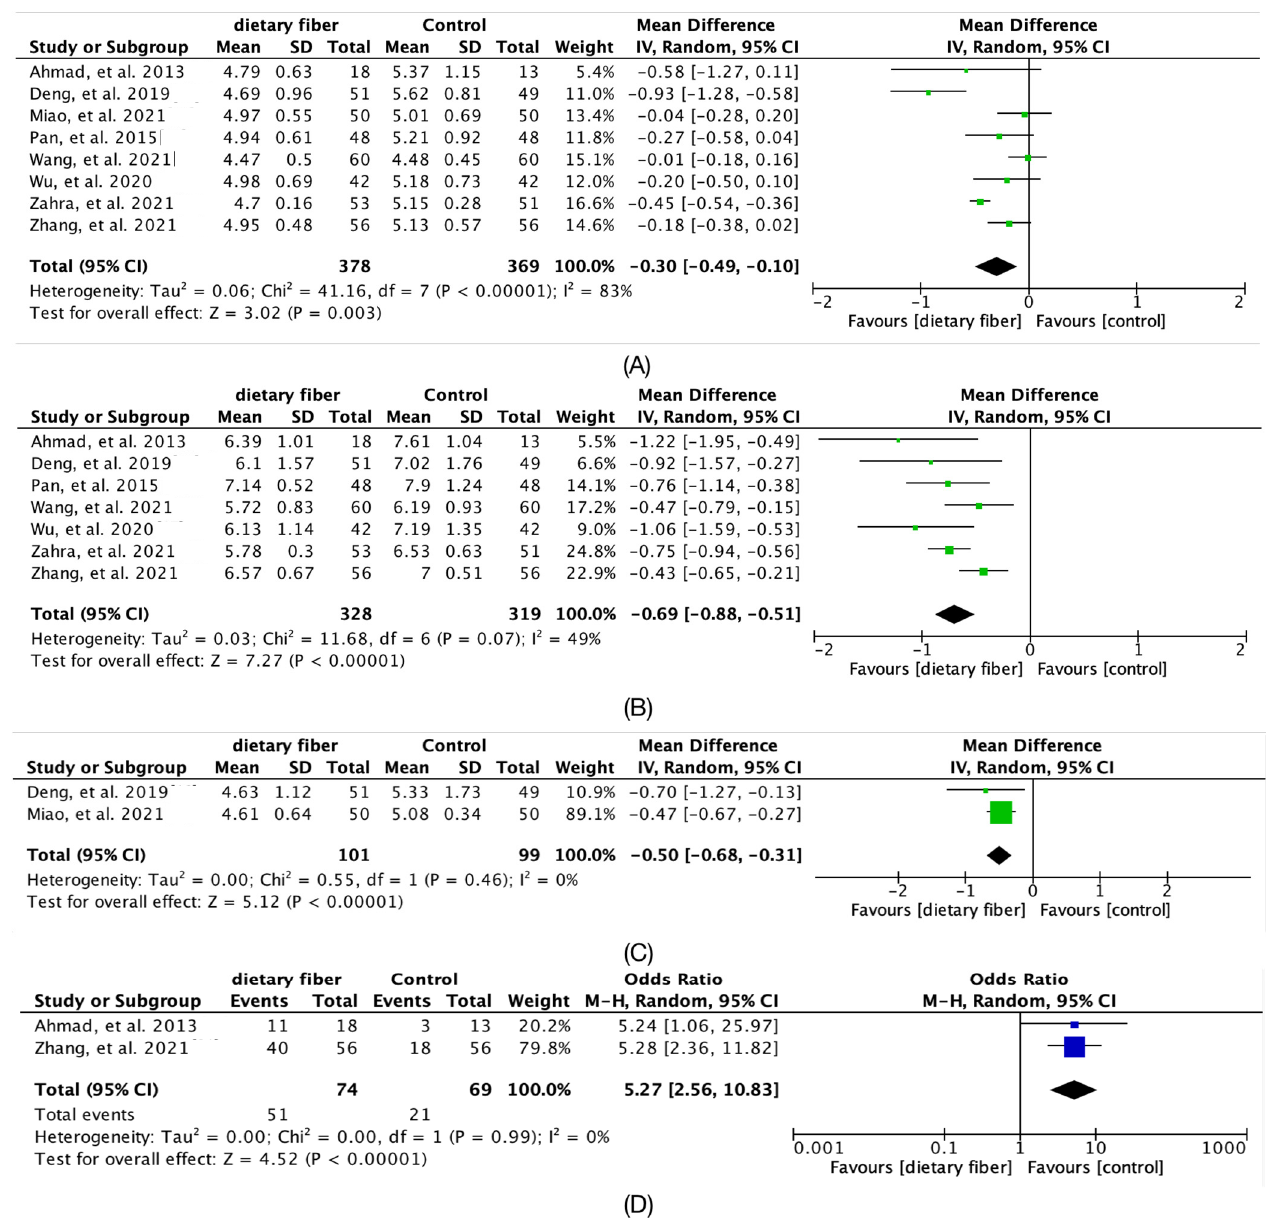
Figure 3. Forest plot for the overall meta-analysis of Serum glucose outcomes: ( A ) fasting glucose (mmol/L); ( B ) 2 h plasma glucose (mmol/L); ( C ) HbA1c (mmol/L); ( D ) Number of qualified blood glucose.[14–21]